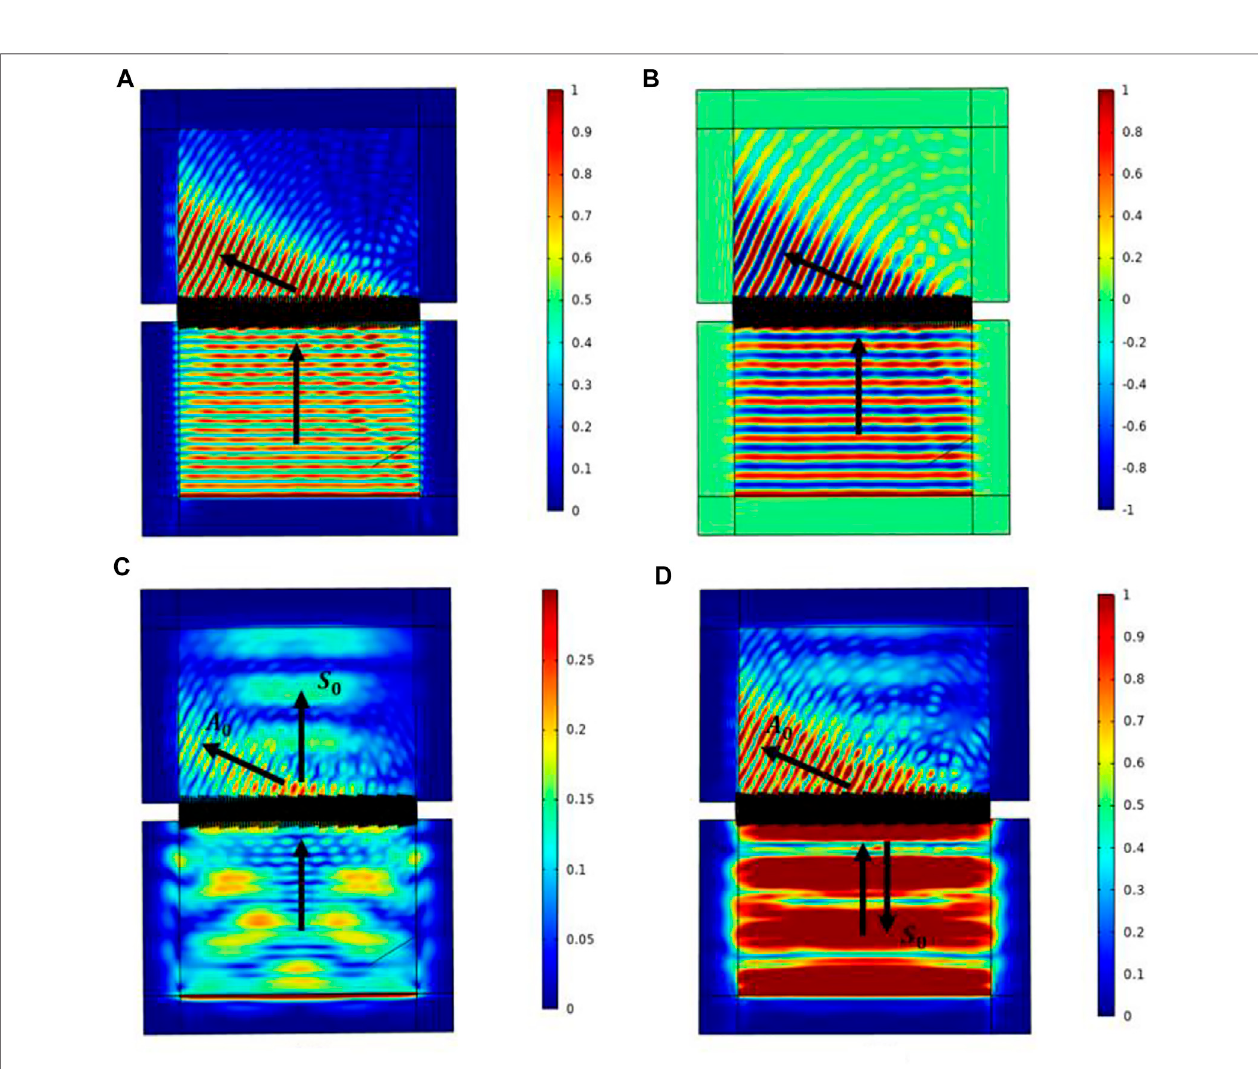
FIGURE 12 | (A) Total displacement corresponding to the fi rst excitation method (combined plot of displacements in three directions); (B) z-directional displacement (off-plane displacement); (C) total displacement corresponding to the second excitation method; (D) total displacement wave fi eld corresponding to the third excitation